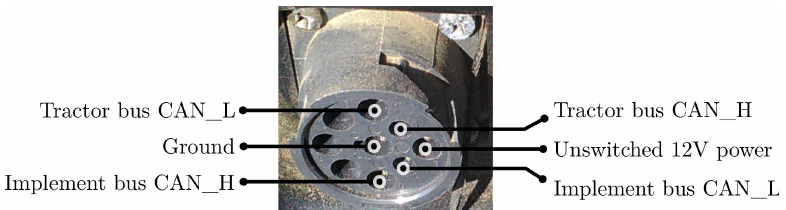
Figure 1. An ISOBUS diagnostic port is an access point for hardware tools to collect CAN data and from modern agricultural machinery.